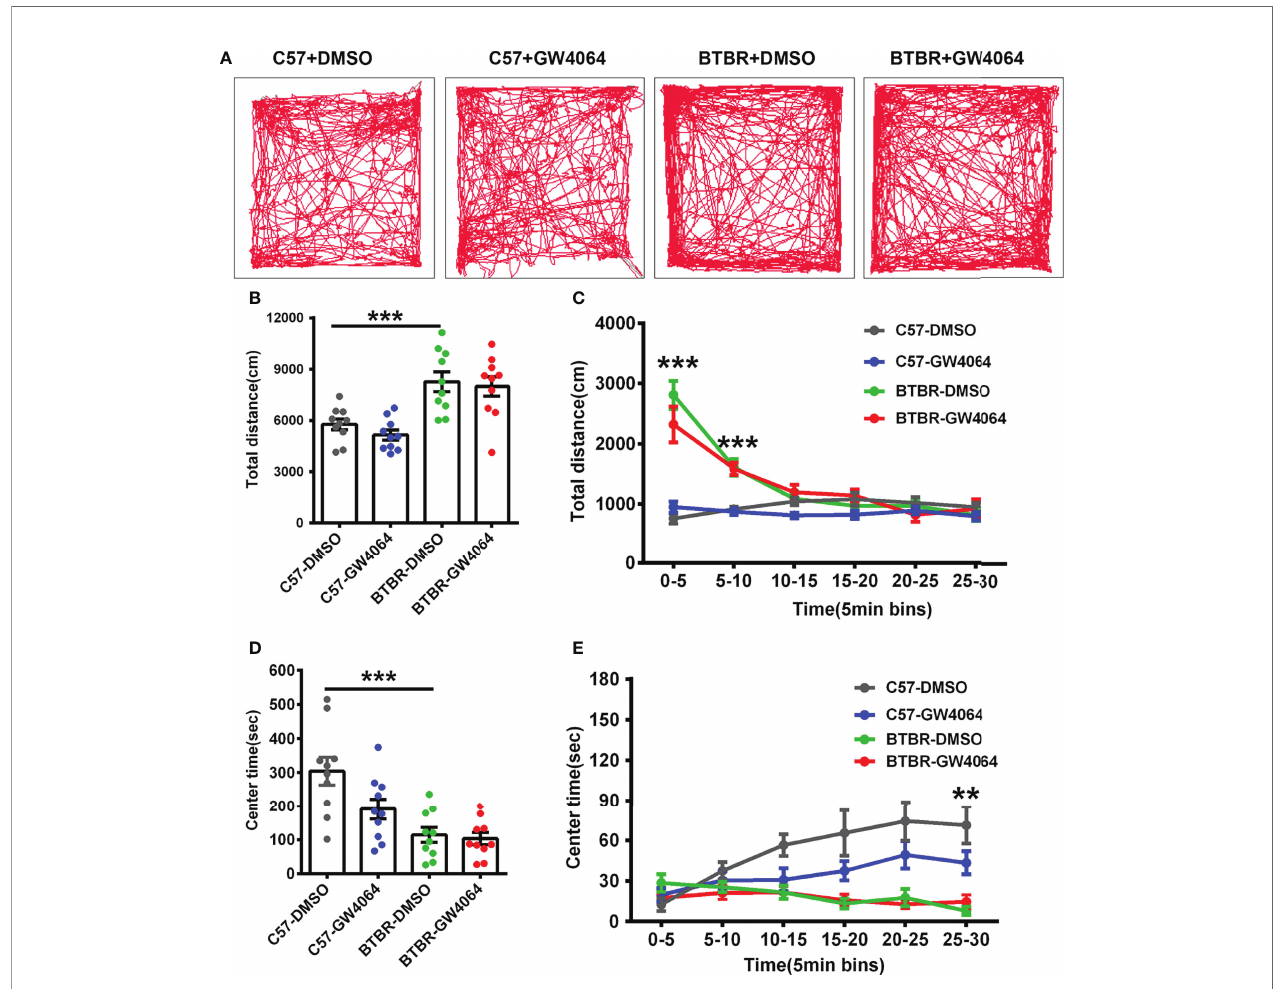
FIGURE 4 | GW4064 treatment did not alter exploratory locomotion and anxiety in the open fi eld test. (A) The representative traces of different groups of mice in the open fi eld test. (B) The activity was measured as the total amount of distance traveled. The BTBR mice showed a stronger exploratory locomotion ability than C57 mice. (D) BTBR mice spent less time in the center in the open fi eld test, and the total time of the 30-minute test in the center was not affected by GW4064 treatment in C57 and BTBR mice. (C, E) A 30-minute assay of distance moved (C) and time in the center (E) were computationally split into six segments with 5 minute per segment. The GW4064 treatment did not have effects on distance traveled and time spent in the center for each 5-minute segment in BTBR mice. The data are presented as the mean ± SEM. n = 10. **p < 0.01; ***p <